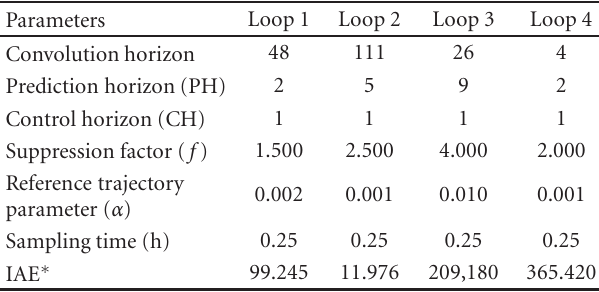
Table 4: Parameters of the DMC to the servo problem.